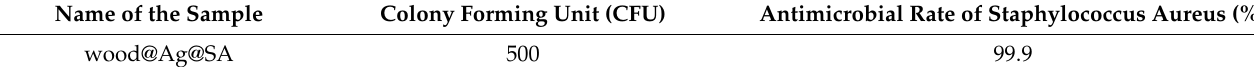
Table 1. The antimicrobial test of wood@Ag@SA.